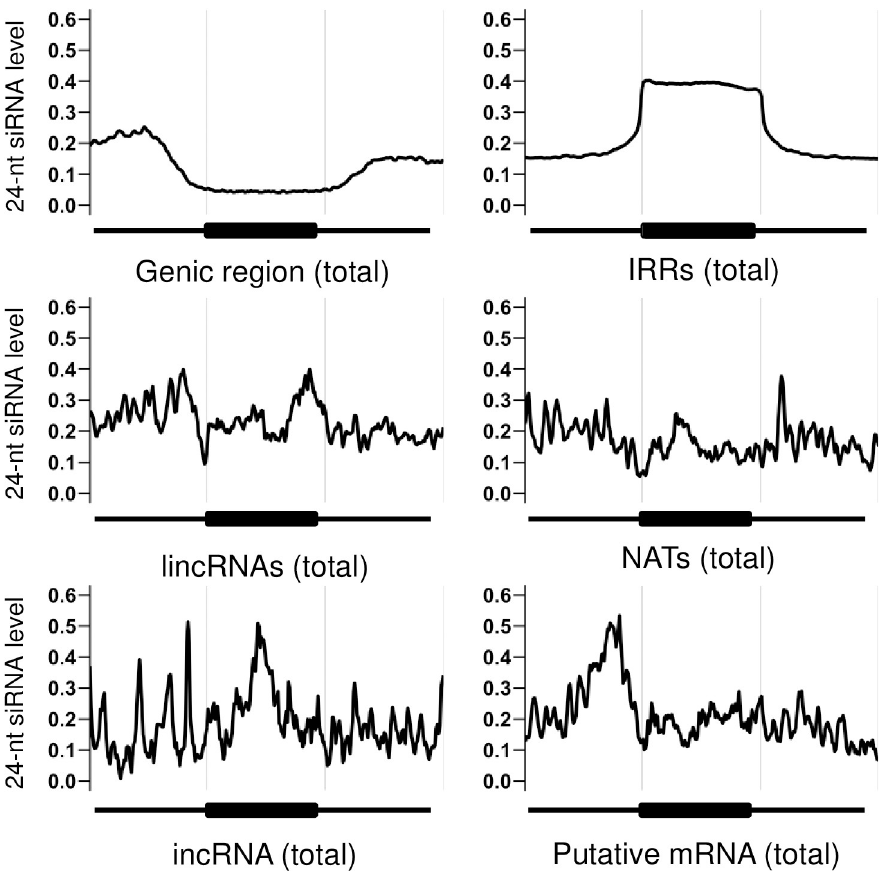
Fig 3. 24nt-siRNAs mapped to genic region, IRRs, putative mRNAs and each type of lncRNAs. The x-axis represents the target region (genic region, IRRs, putative mRNAs, or lncRNAs) and the flanking 5’ and 3’ regions. The y-axis represents the reads per million (RPM) value of 24-nt siRNA that overlaps with the corresponding target region.